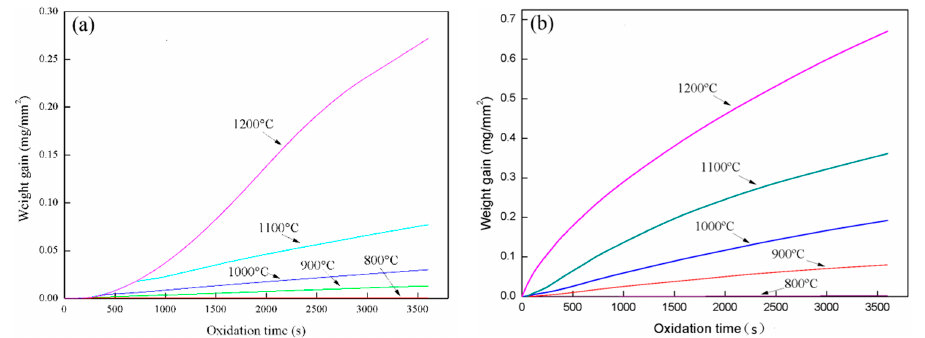
Figure 1. Oxidation weight gain curves of Fe–10Cr steel under different atmospheres: ( a ) air; ( b ) air with 50% water vapor.